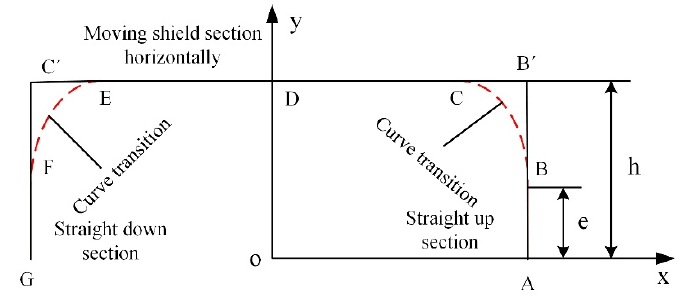
Figure 7. The motion trajectory of the execution